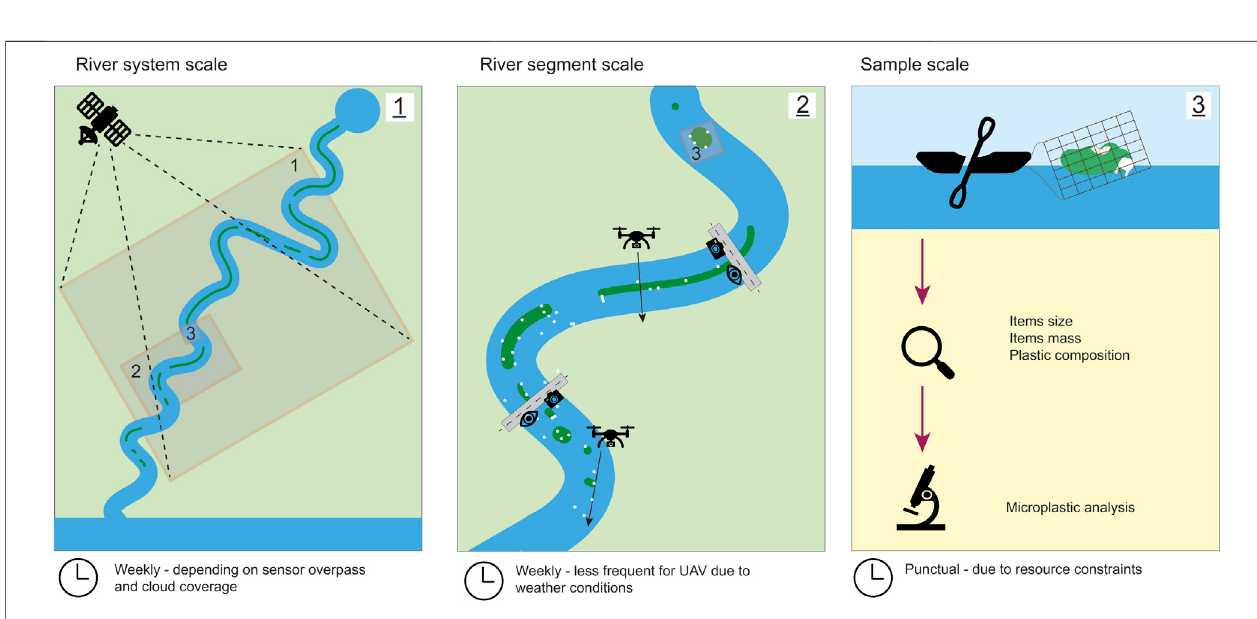
Frontiers in Environmental Science |